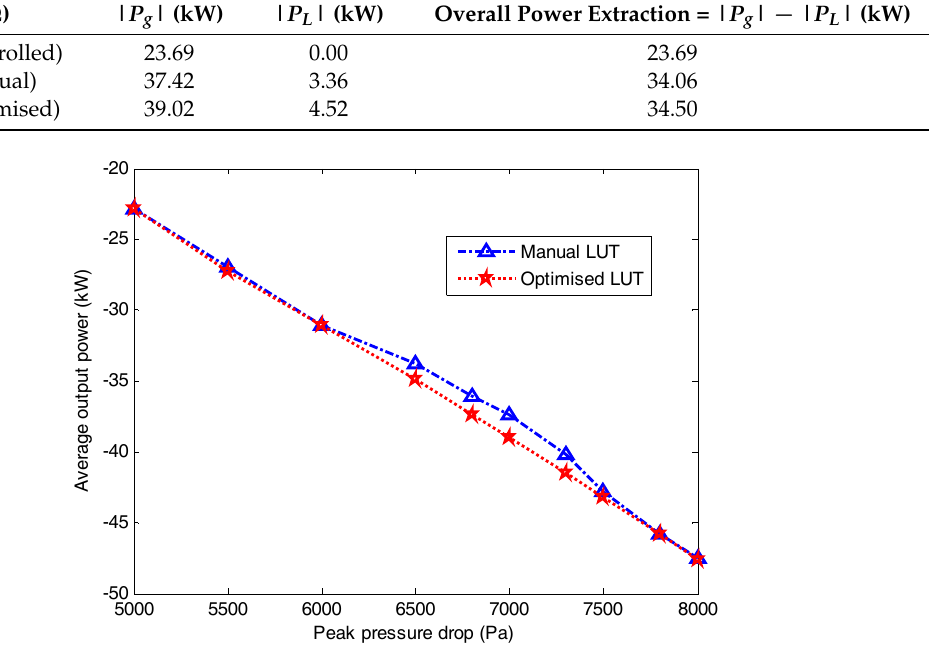
Figure 7. Comparison of average output power between manual and optimised LUT.